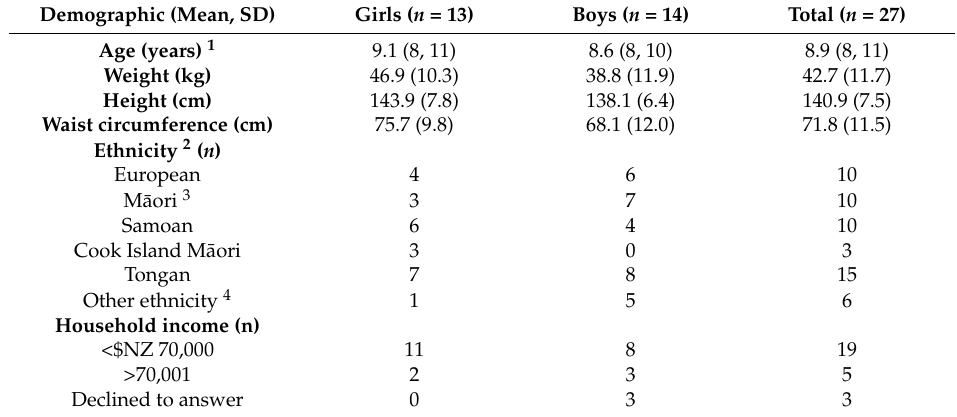
Table 1. Demographics of the 27 children who participated in the